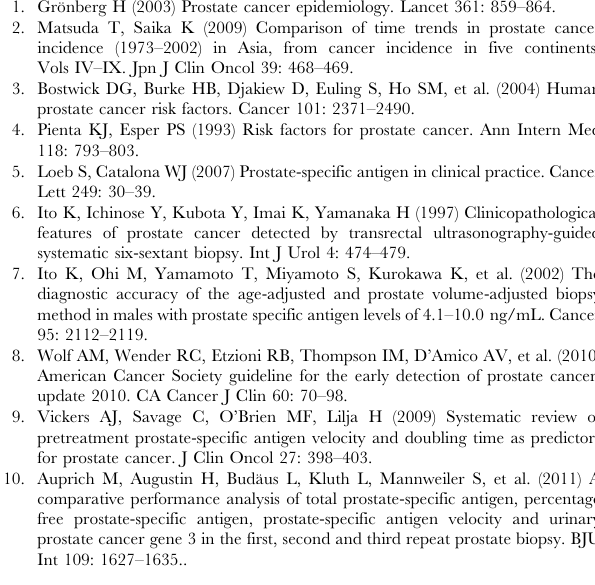
Figure S3 Correction between serum PSA level and OR. Serum PSA level and OR are plotted for all the case and control samples with PSA 1–10 ng/ml, and the correlation coefficient (R 2 ) is indicated. (TIF) Figure S4 A risk prediction model created by step-wise logistic regression. ROC analysis of a risk prediction model created by step-wise logistic regression. 9 variants that remained significant were incorporated into the model. The ROC plot is based on the combined data of all three sample sets used in the present study. The AUC of the model and 95% confidence intervals are indicated. The AUC of the model is statistically compared with that of the model created by unconditional logistic regression based on 16 SNPs by DeLong’s test, and the P -value is reported. (TIF) Figure S5 The distribution of odds ratio in high and non-high risk tumors. Distribution of odds ratio in AKY are plotted separately in high (red) and non-high (blue) risk tumors. High risk tumors fulfill either of the following criteria; PSA $ 20, or GS $ 8, or clinical stage $ C. Odds ratio between high and non- high risk tumors are statistically compared by Student’s t -test, and the P -value is reported. Y -axis shows cumulative